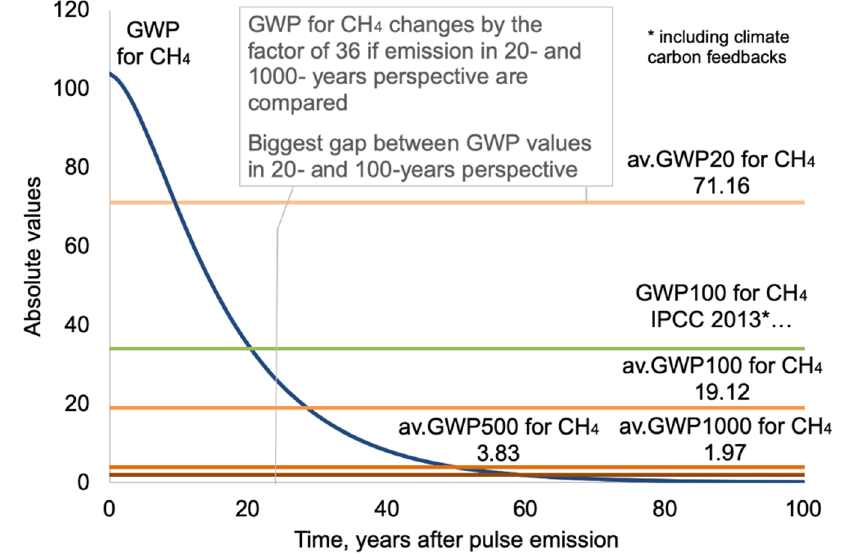
Figure 12. Absolute GWP values for CH 4 emissions given using the BCCM named “GWP for CH 4 ” and average GWP values for the first 20 years after pulse emission of CH 4 named “av.GWP20 for CH 4 ” and has the value of 71.16, for the first 100 years—“av.GWP100 for CH 4 ”; for first 500 and 1000